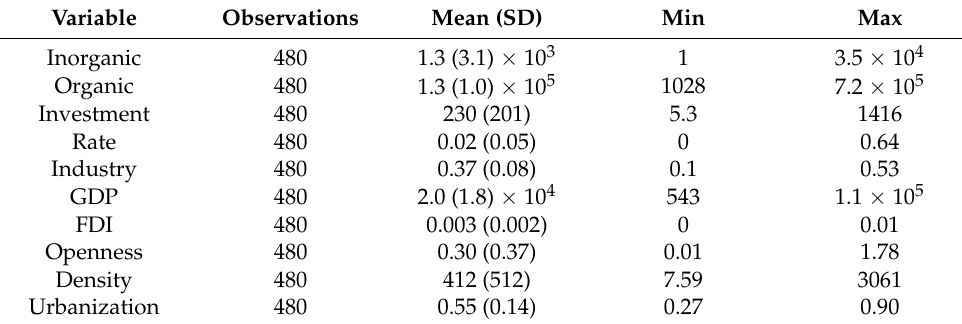
Table 2. Descriptive statistics of variables in the